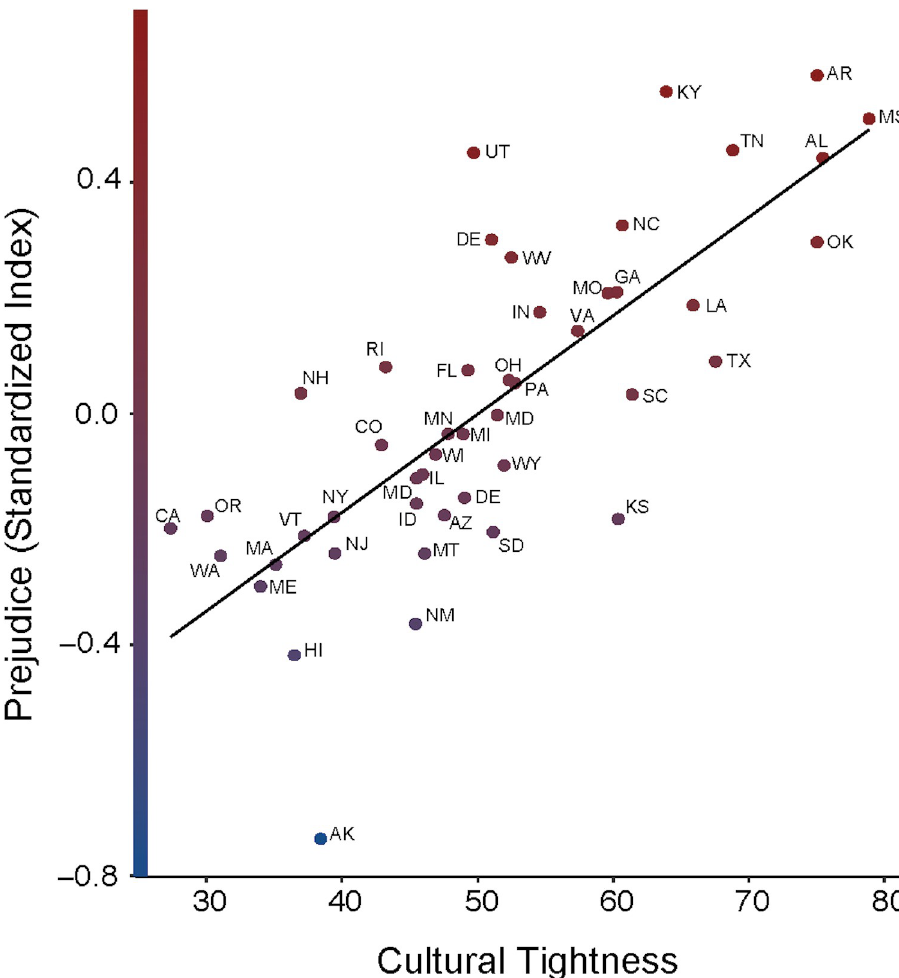
Fig 2. The relationship between cultural tightness and prejudice. Prejudice has been standardized in this figure. Prejudice is operationalized through the intolerance of a close relative marrying Black, Asian, Hispanic, and Jewish